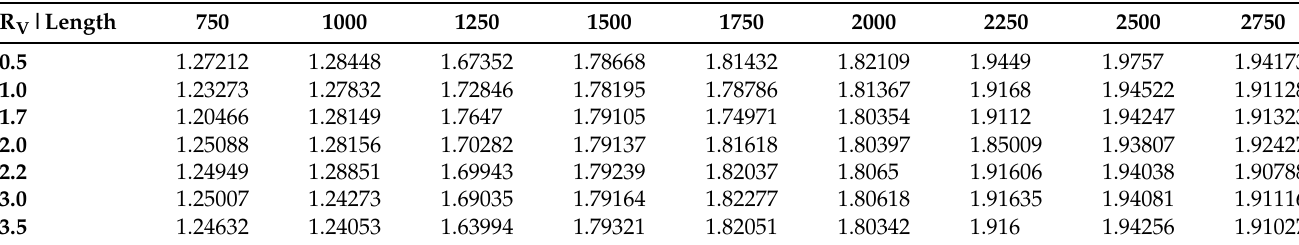
Table A16. Execution times in milliseconds on GPU with ring structure for 30,000 time-steps (1.5 s); R V on the Left and number of cells (length) on the Top